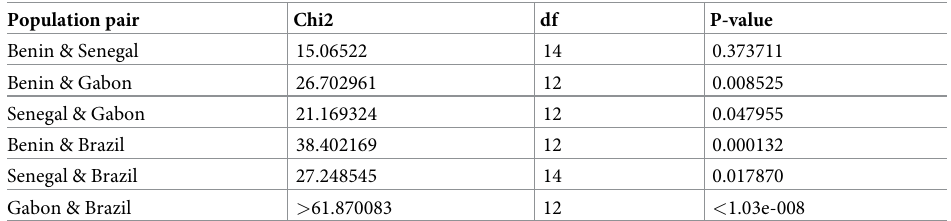
Table 3. P-value for each population pair of countries across all loci (Fisher’s method). Population pair